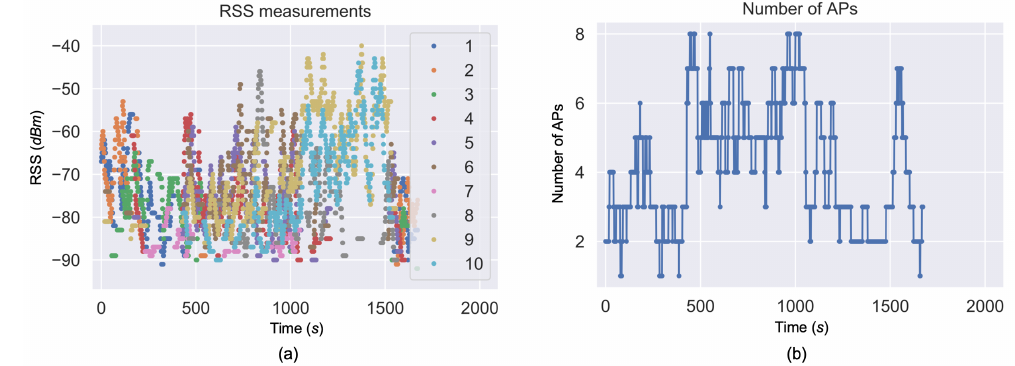
Figure 7. RSS time series ( a ) and number of available APs ( b ).